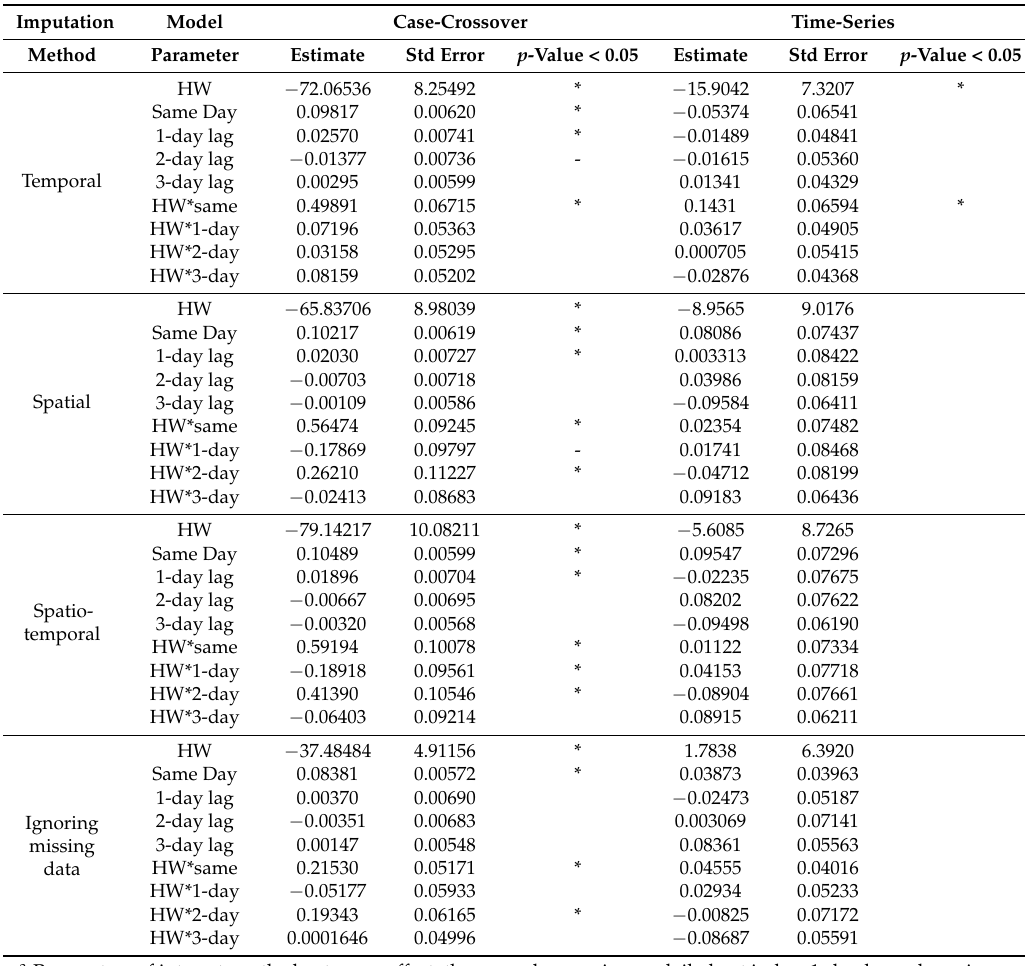
Table 5. Case-crossover and time-series results for the Melbourne (MLB) region using the temporal, spatial and spatio-temporally imputed data and the method ignoring missing data a,b